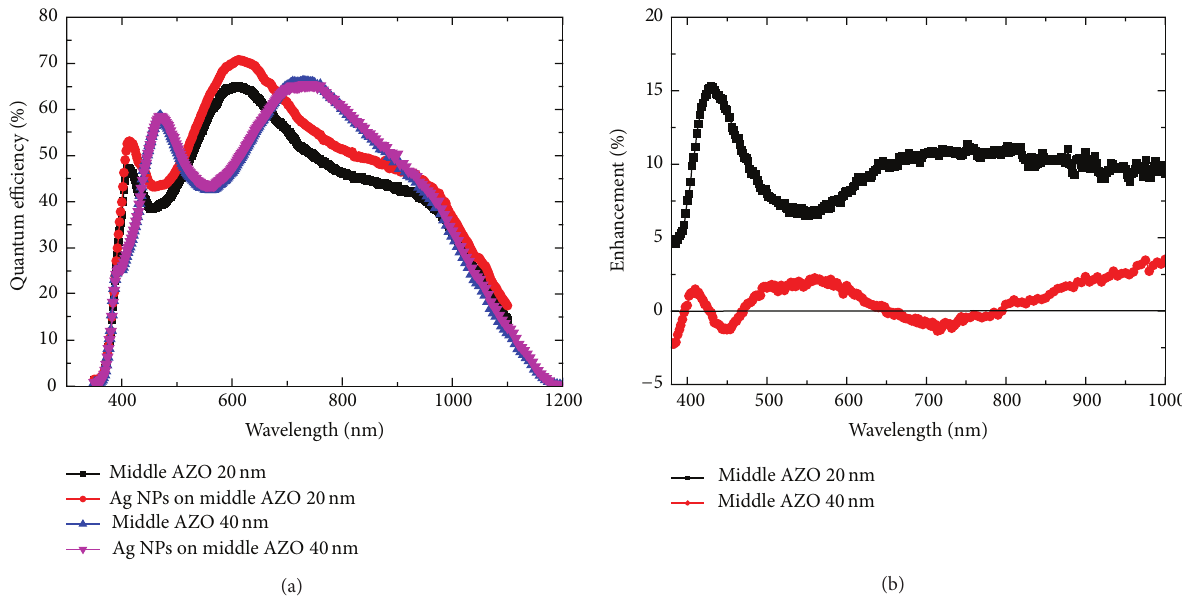
Figure 10: (a) Quantum efficiency spectra of AZO middle layers of 20, 40 nm thicknesses and the same layers coated with Ag nanoparticles; (b)QuantumefficiencyenhancementofAZOlayersofthicknessesof20and40 nmwithoutAgNPs,showingQEmainlydependsonthickness of middle AZO layer